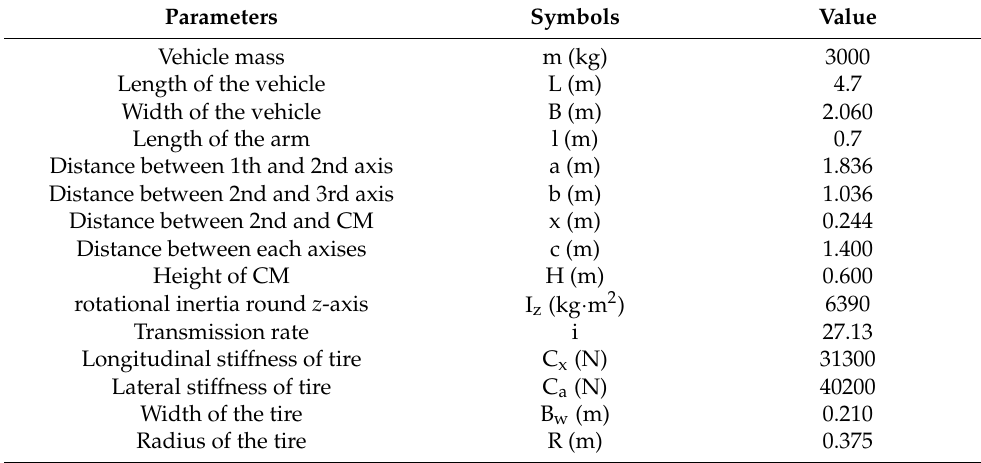
Table 1. Vehicle intrinsic parameters.